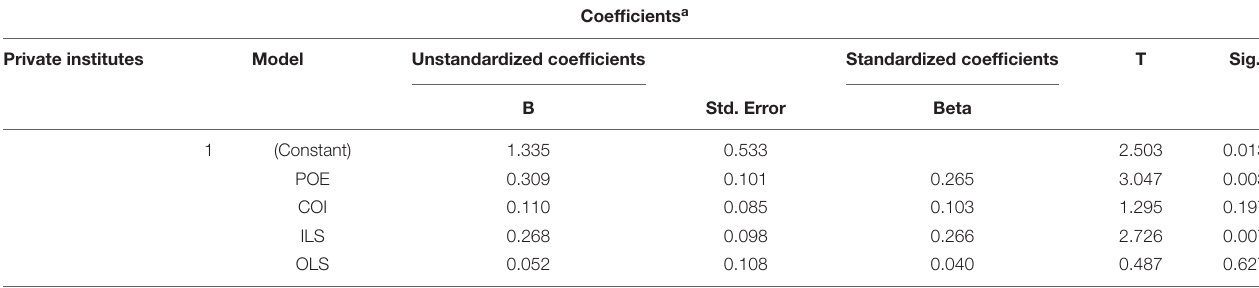
TABLE 11 | Coefficients of Grit and L2MSS for private institute